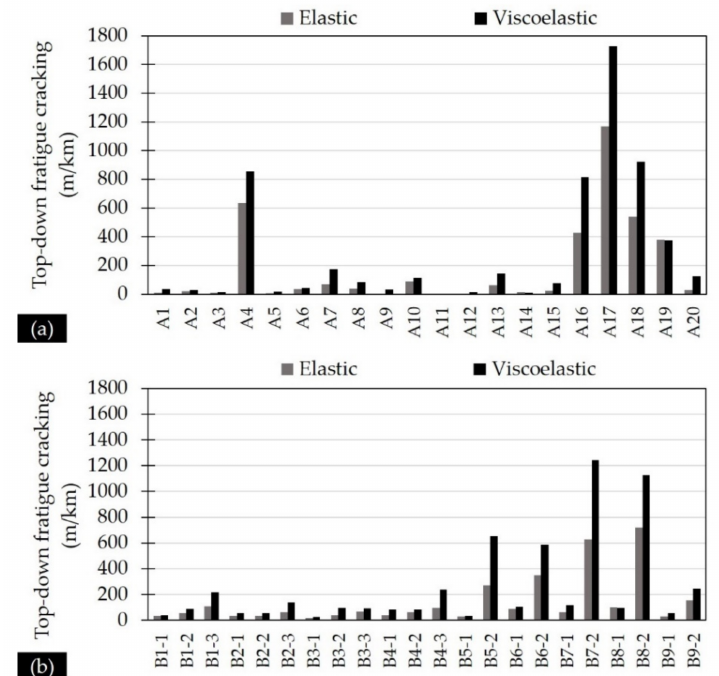
Figure 15. Longitudinal cracking prediction (top-down fatigue failure) for cross-sections at ( a ) pavement A and ( b ) pavement